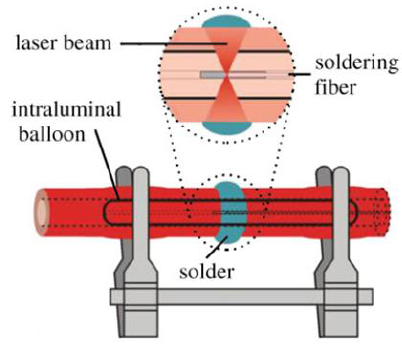
Figure 6. Schematics of the laser-assisted vessel soldering [51].